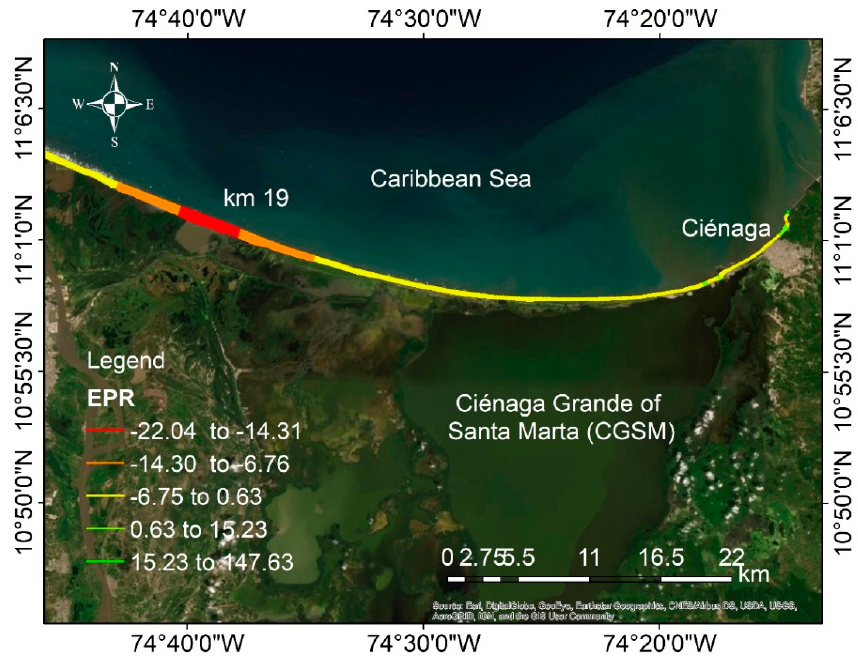
Figure 10. Coastline evolution, 1973–2016. End point Rate (EPR) in meters per year is calculated by dividing the distance between the movement of the shoreline and the time elapsed between the oldest and the latest measurements.